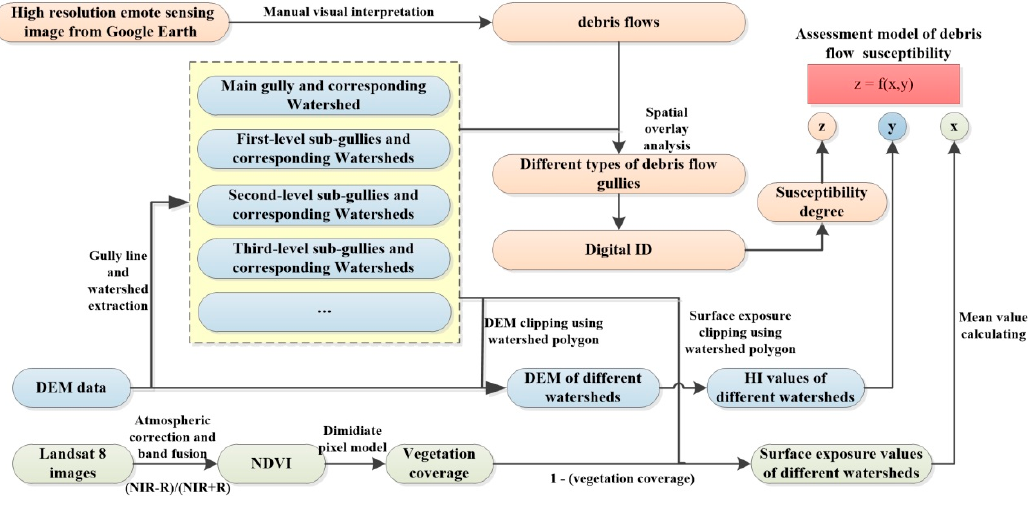
Figure 6. Technology roadmap.